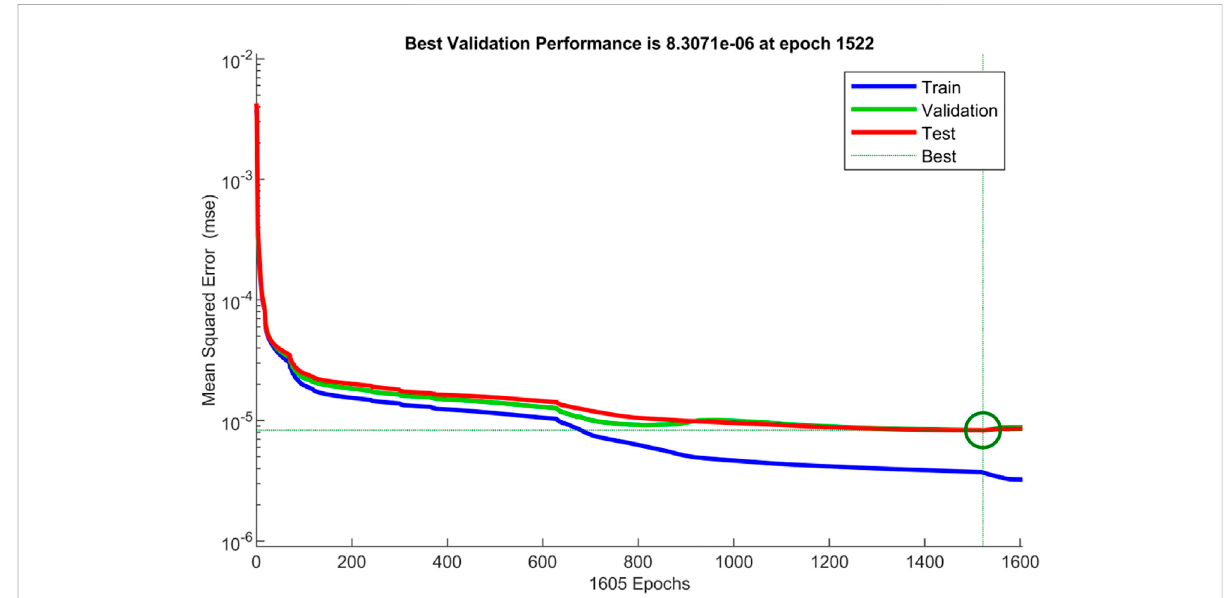
FIGURE 8 Training curve of the relevant parameter-based ANN black-box model (RPANN).